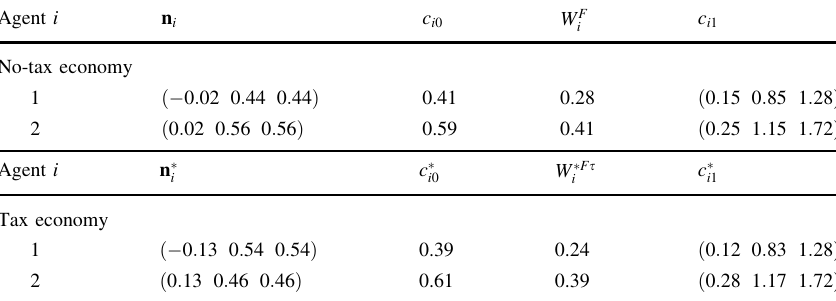
Table 6 Summary of agents’ portfolios, consumption and wealth in the no-tax and the tax economy Agent i n i c i 0 c i